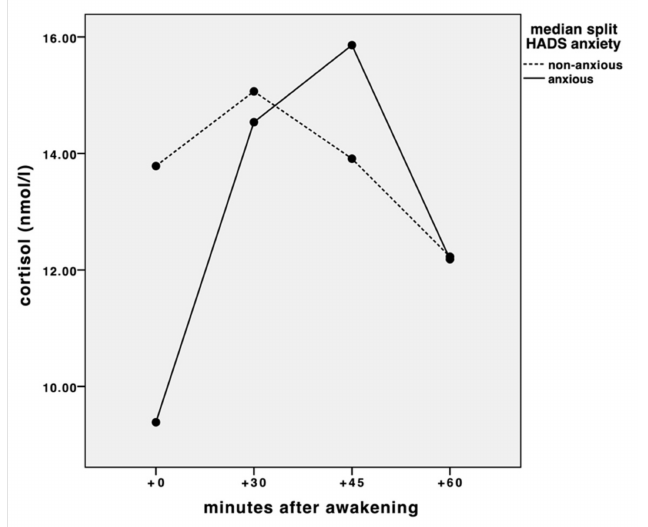
Figure 1. Cortisol awakening response (CAR) in anxious versus non anxious subjects (+0, +30, +45, +60 min after